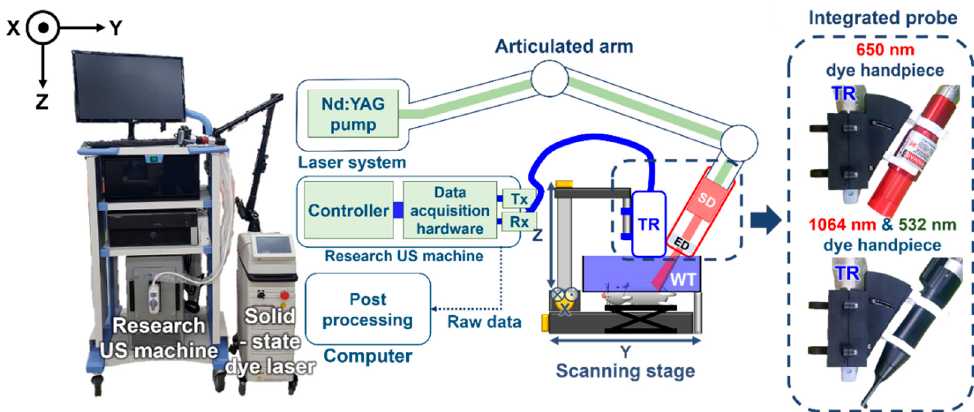
Figure 1. Photograph and schematic of dual-modal photoacoustic and ultrasound imaging system with a solid-state dye laser (SD-PAUSI). US, ultrasound; Tx, transmit; Rx, receive; TR, transducer; WT, water tank; ED, engineered diffuser; SD, solid-state dye.